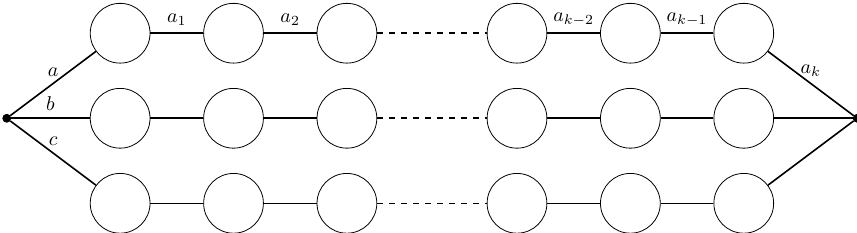
Fig. 7: Each circle stands for a 2 -connected cubic graph with one edge deleted. The two resulting vertices of degree 2 are connected along the path a, a over such graphs are 4 -connected 4 -regular (see [3]). They may be Hamiltonian but definitely not prism-